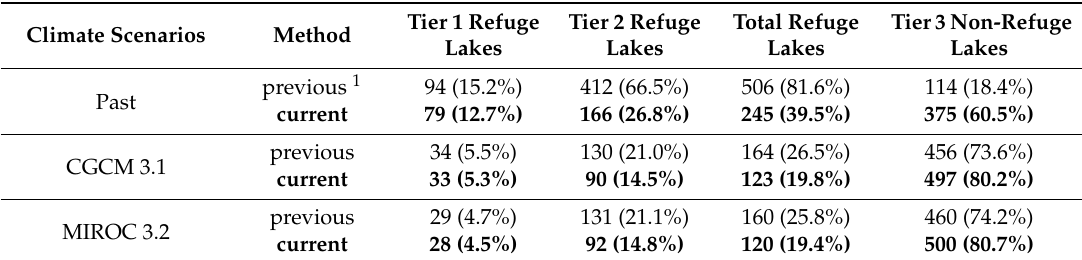
Table 9. Number (%) of cisco lakes selected as Tier 1 and Tier 2 refuge lakes and Tier 3 non-refuge lakes from the 620 cisco lakes using the two